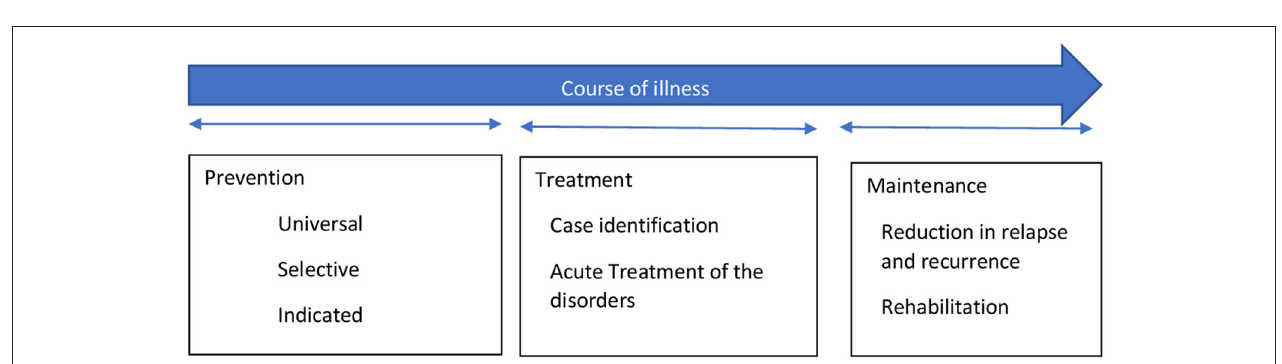
FIGURE 2 | The interventions for mental illness as classified by the Institute of Medicine (IOM) Committee on Prevention of Mental Disorders [adopted from Mrazek and Haggerty ( 48)].